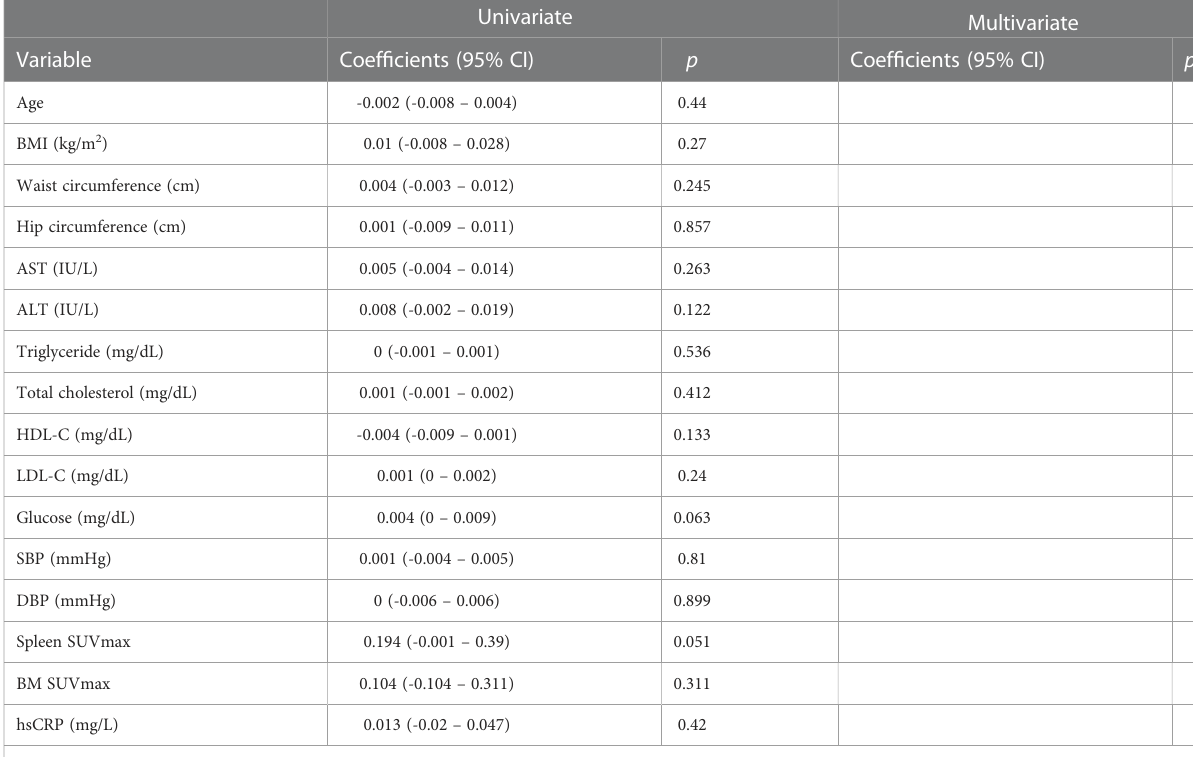
TABLE 4 Univariate- and multivariate analysis with AmygA as a dependent variable at post-exercise obese women.